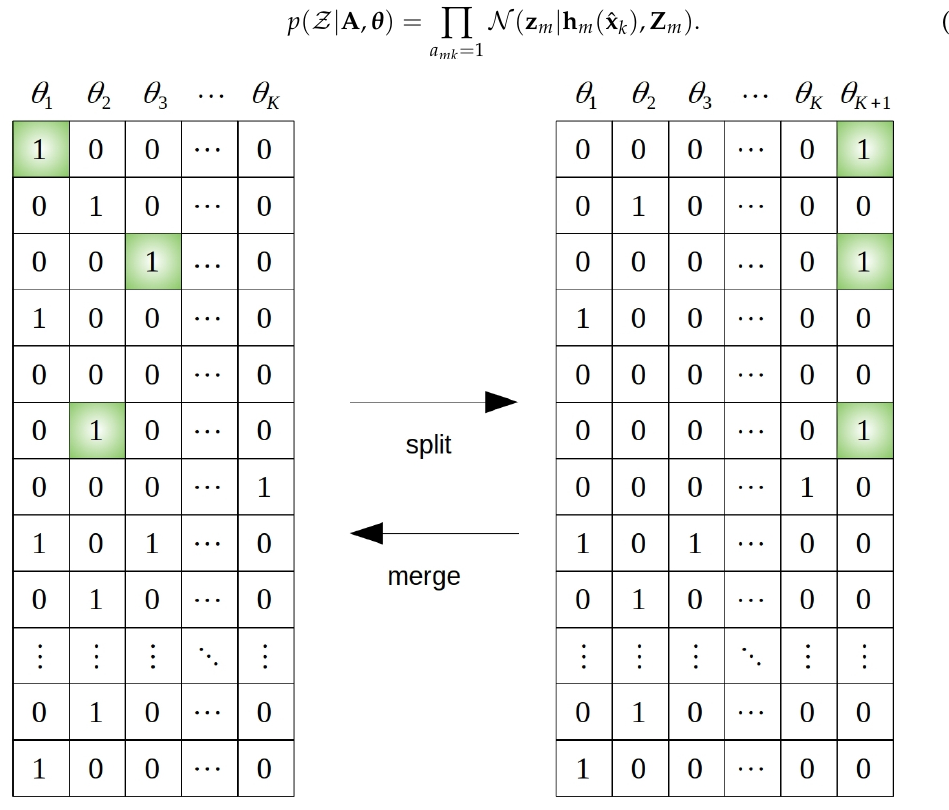
Figure 3. Matrix visualisation of the reversible split-and-merge move. Here, we mainly focus on the target-to-track association and omit the differences between bistatic spaces (although we assume the association to be consistent). Columns are labelled by θ j , which denotes the j -th target rather than the target state vector x j or its estimate ˆ x j